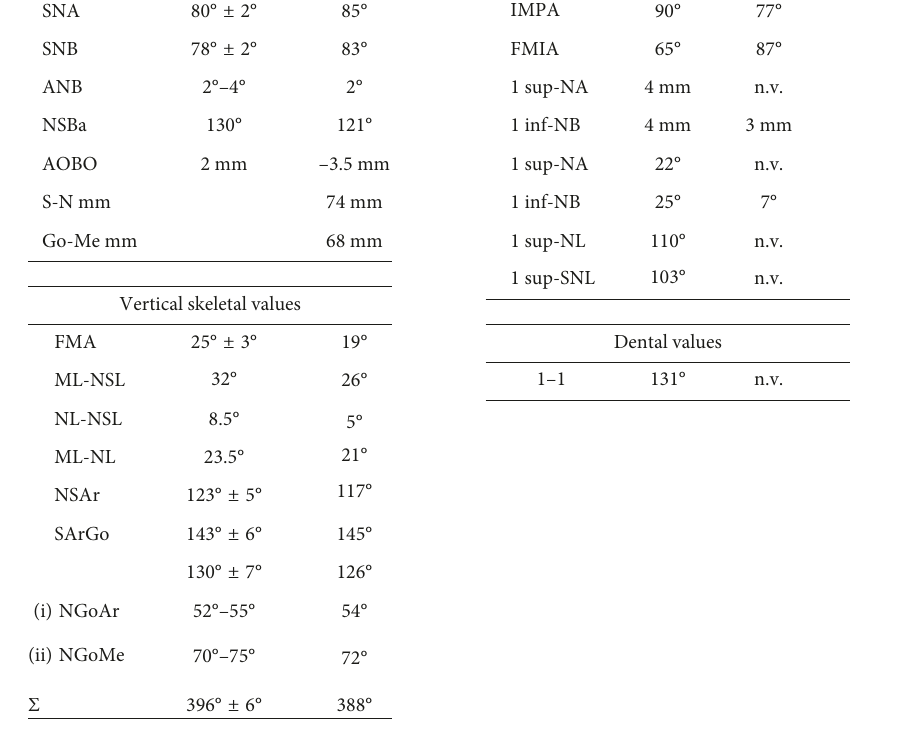
Figure 7: Cephalometric analysis.